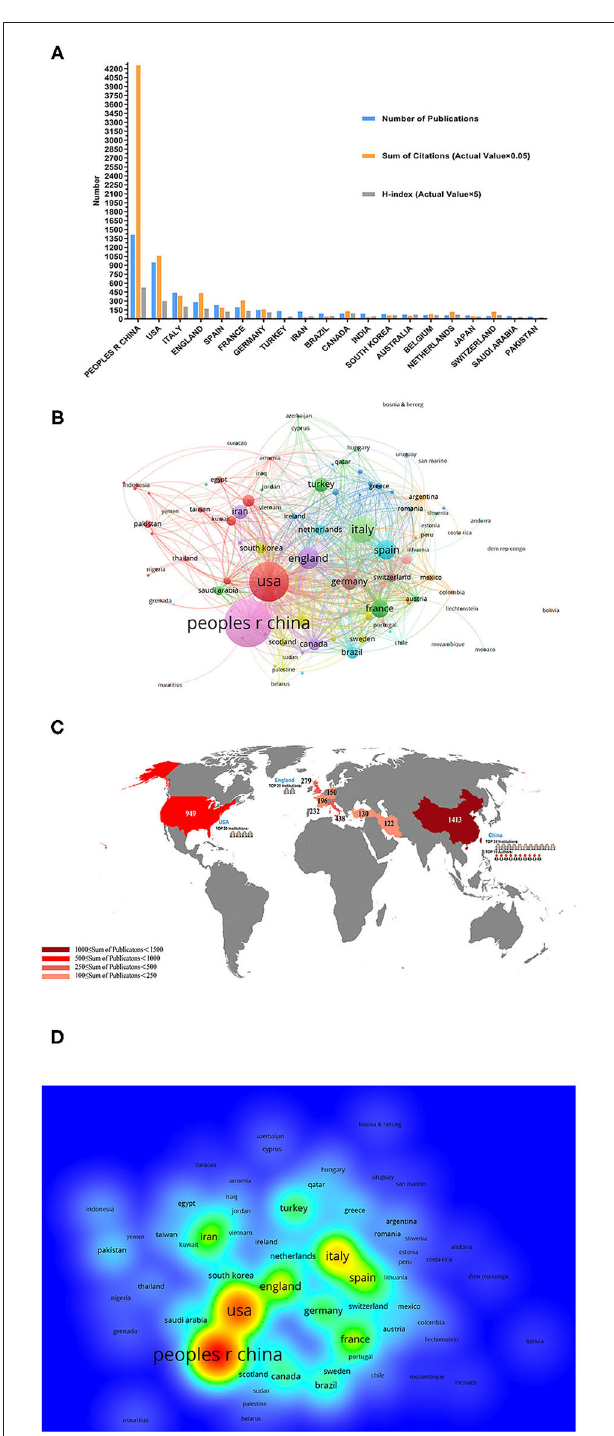
FIGURE 2 | Contributions of different countries/regions to the research studies regarding coronavirus disease-2019 (COVID-19). (A) The number of publications, citation frequency ( × 0.05), and H-index ( × 5) of the top 20 countries or regions with the highest number of publications. (B) Bibliometric analysis of citations by country. Different colors indicate different clusters, and the size of circles reveals the number of citations. (C) The number of publications regarding COVID-19 worldwide. (D) Density map of